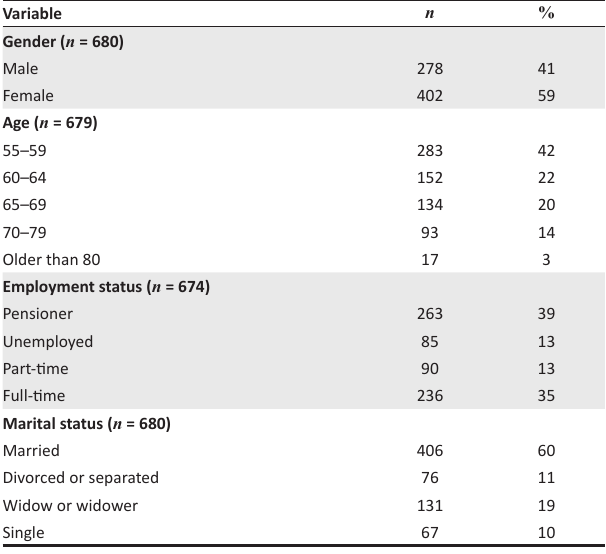
FIGURE 2: Factors that influence the mall shopping patronage of mature TABLE 3: Survey sample demographic profile.